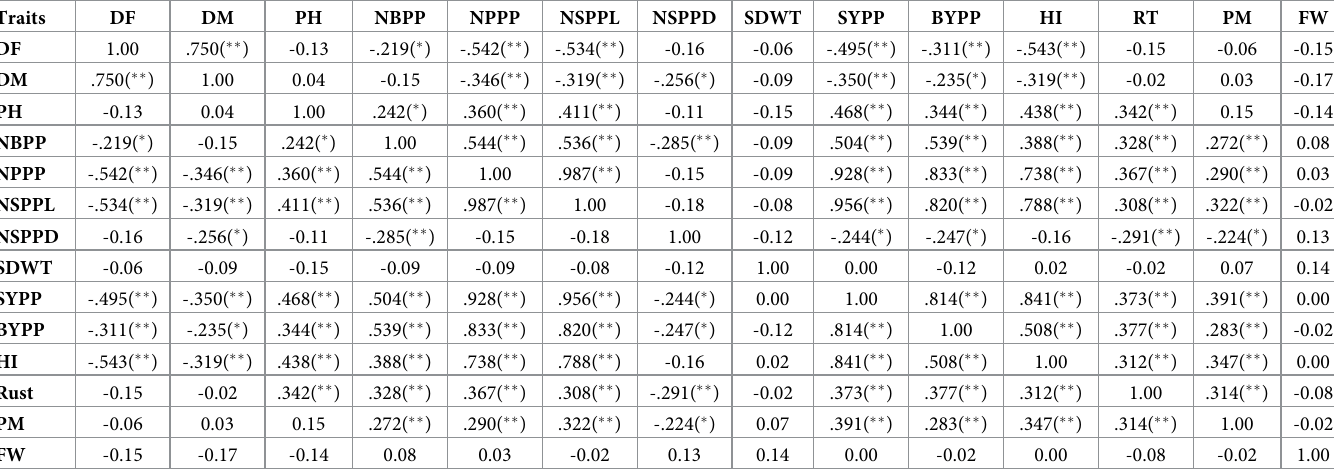
Table 2. Correlations among various agro-morphological traits of wild lentil accessions.